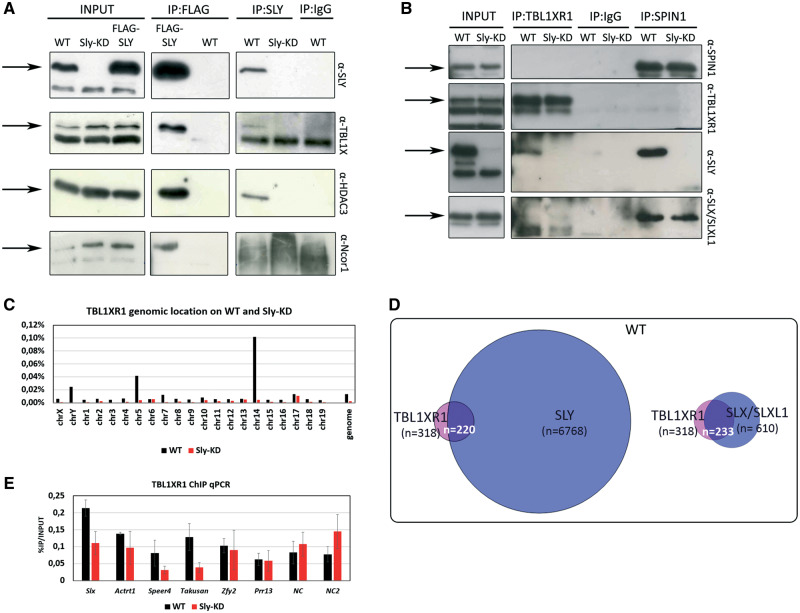
SMRT/N-Cor proteins interact preferentially with SLY and are enriched at TSS of the same genes. (A) Western blot detection with SLY, TBL1X, HDAC3, or N-COR1 antibody following immunoprecipitation (IP) with SLY or FLAG antibody on WT, FLAG-SLY, or Sly-KD testis. Immunoprecipitation with IgG was used as negative control. Input samples represent protein extracts before immunoprecipitation. Arrows indicate bands at the right size. (B) Western blot detection with SPIN1, TBL1XR1, SLY, or SLX/SLXL1 antibody following immunoprecipitation (IP) with TBL1XR1 or SPIN1 antibody on WT or Sly-KD testis. Immunoprecipitation with IgG was used as negative control. Input samples represent protein extracts before immunoprecipitation. Arrows indicate bands at the right size. (C) TBL1XR1 genomic location (% of coverage of each chromosome) as identified by ChIP-Seq on WT and Sly-KD round spermatids. (D) Venn diagrams representing the number of common target genes between TBL1XR1, SLX/SLXL1 (Exp1 see supplementary table S2, Supplementary Material online), and SLY (from Moretti et al. [2017]) in WT round spermatids. (E) TBL1XR1 ChIP-qPCR performed on WT and Sly-KD round spermatids. The Y-axis represents the mean enrichment (% IP/input) ± SEM (n = 3–4 samples per genotype). A significant difference (t-test, P < 0.05) was found for Slx, Speer4, and Takusan genes.